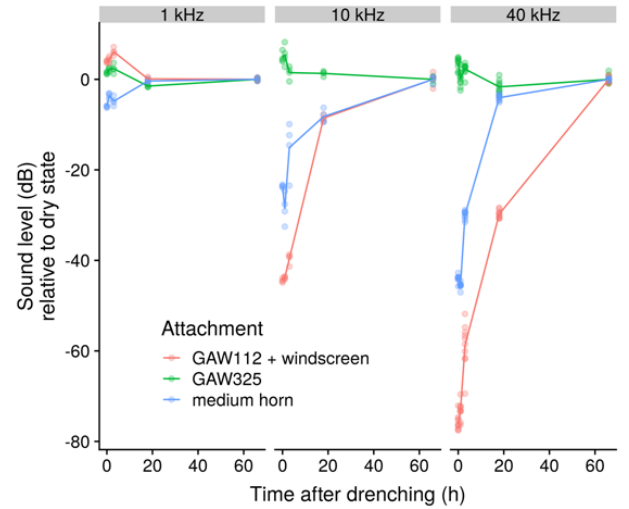
Figure 5. Recorded sound levels with drying time for different microphone configurations (GAW112 and GAW325 are acoustic vents) at different frequencies.